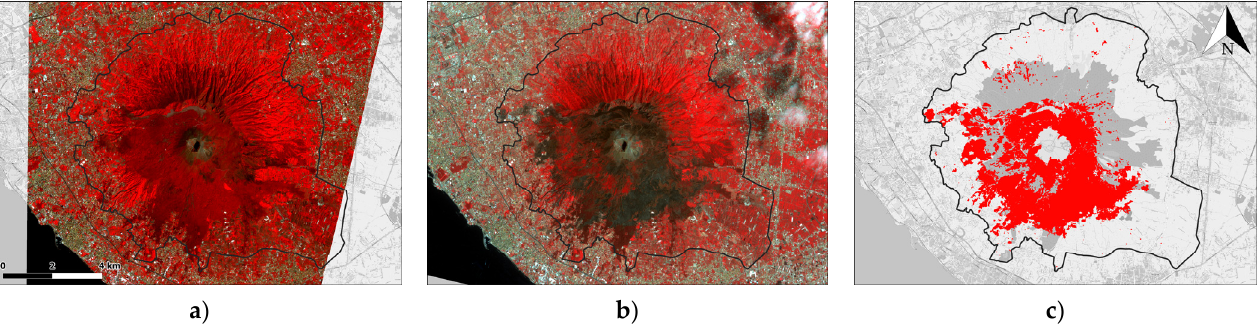
Figure 3. Pre- ( a ) and post-fire ( b ) PlanetScope images: 22 April and 22 July 2017, over the Vesuvius sites. Images are displayed as RGB false color composites (NIR, red, green) and the reference burned area map ( c ) obtained with RF algorithm. Black polygon shows the border of Vesuvius National Park.